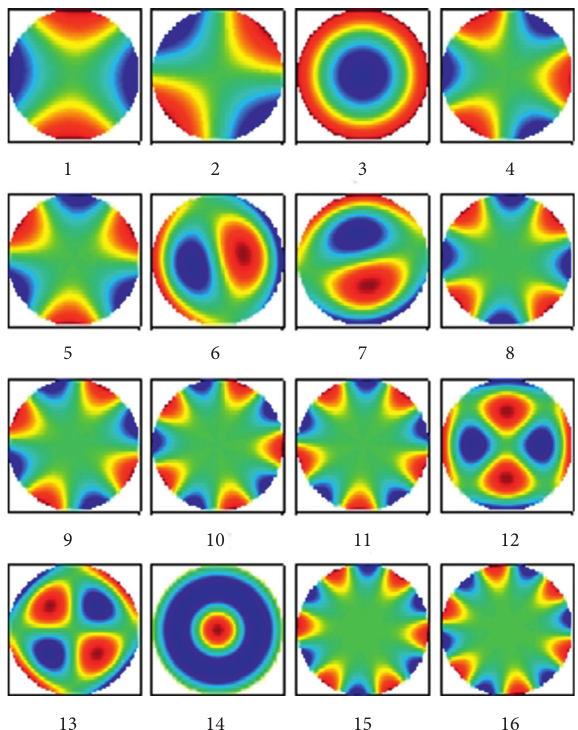
Figure 3: Mode shape contour maps from the FE model.